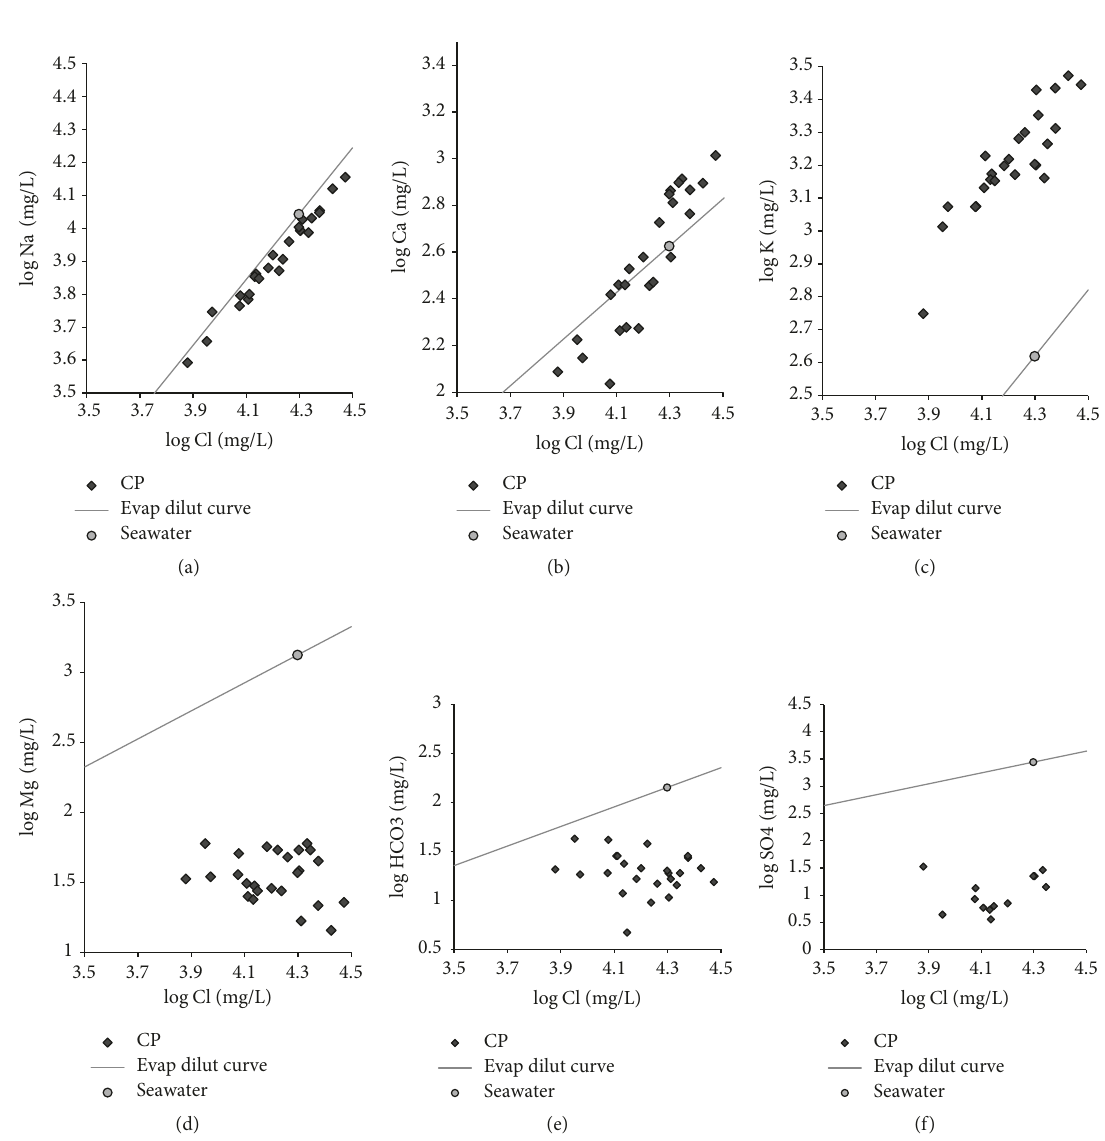
Figure 2: Variations in dissolved (a) Na + , (b) Ca 2+ , (c) K + , (d) Mg 2+ , (e) HCO 3− , and (f) SO 42− concentrations as a function of dissolved chloride concentration. The solid line on each plot is the seawater evaporation-dilution curve for each cation; circle is the ionic composition of